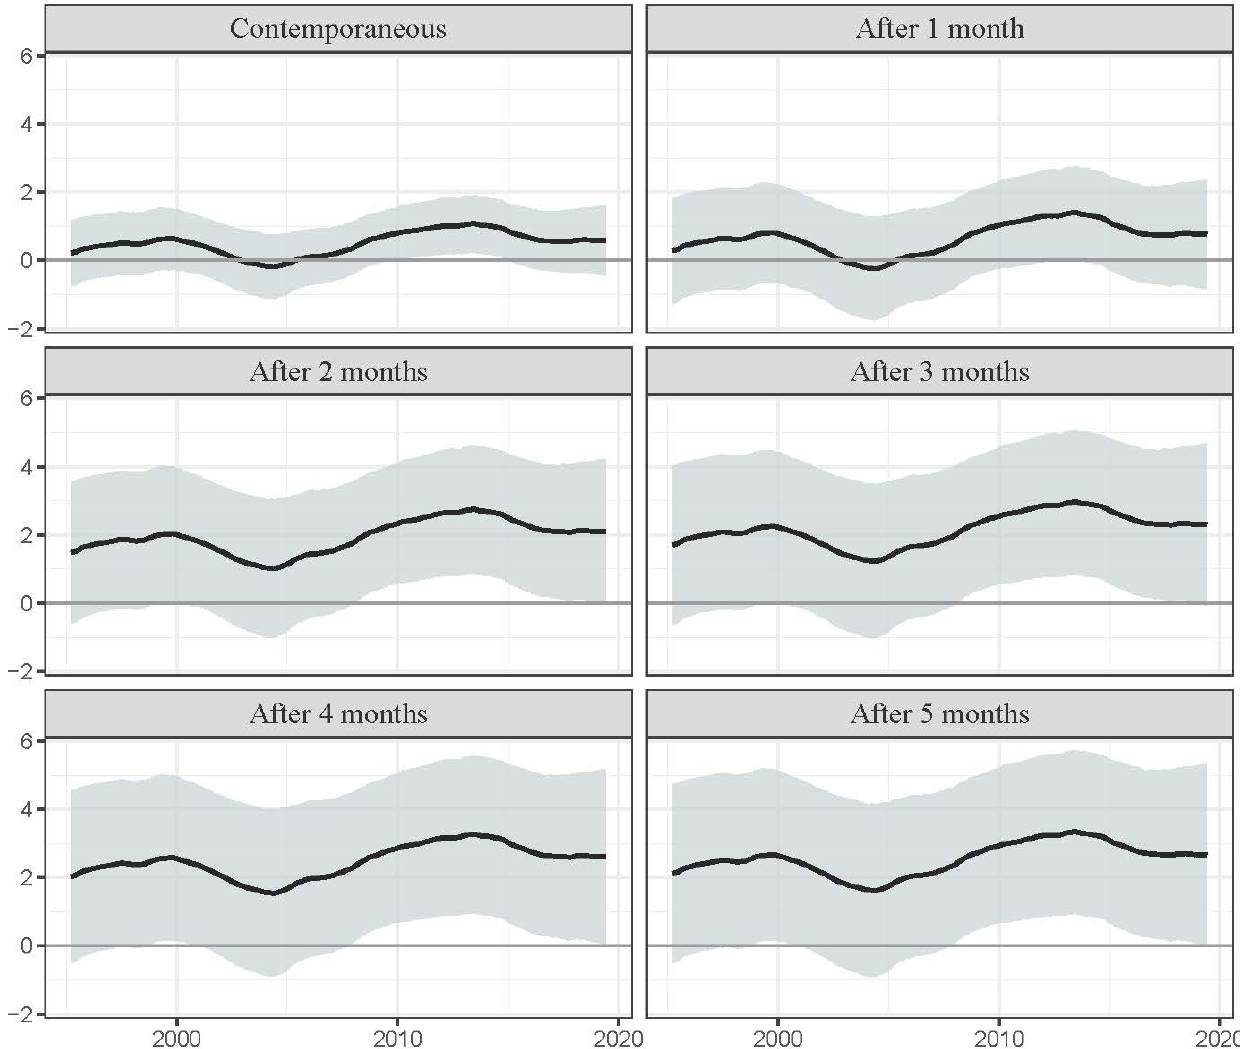
Figure 5. Responses of stock returns to an aggregate demand shock. Note: This figure presents the accumulated responses of stock returns to a one-unit aggregate demand shock in the first five months after the shock (1995:04–2019:06). The solid black line shows the mean while the gray area displays the 16th and 84th percentiles.